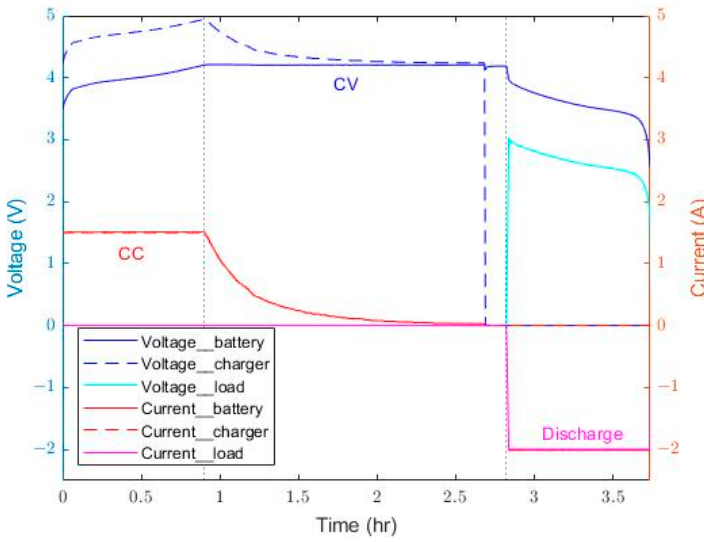
Figure 3. CC-CV charging and discharging process of Li-ion battery.